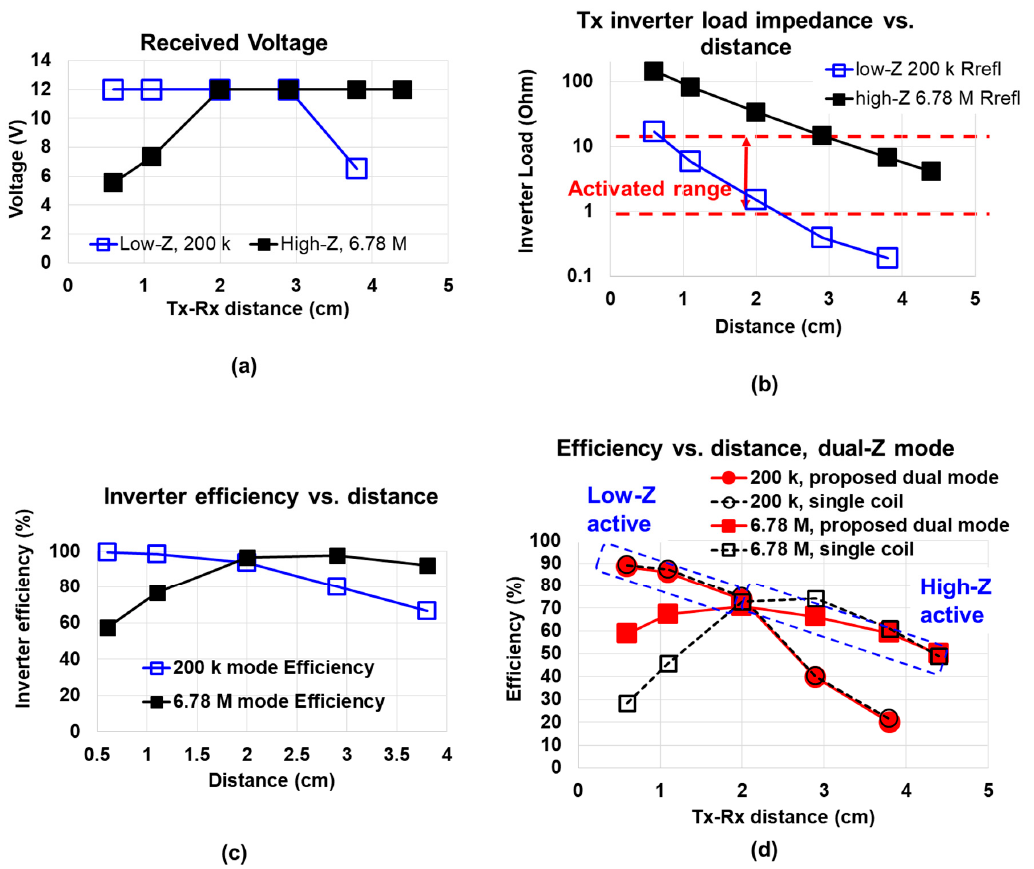
Figure 6. ( a ) Received voltage for conventional standalone single coil. A single configuration cannot accommodate the full distance range. ( b ) Measured reflected resistance for standalone low-Z and ffi ciency. ( d ) Measured e ffi ciency. The degradation from conventional high-Z coils. ( c ) Simulated inverter efficiency. ( d ) Measured efficiency. The degradation from coils. ( c ) Simulated inverter e di ff erent standalone impedances into one dual-impedance